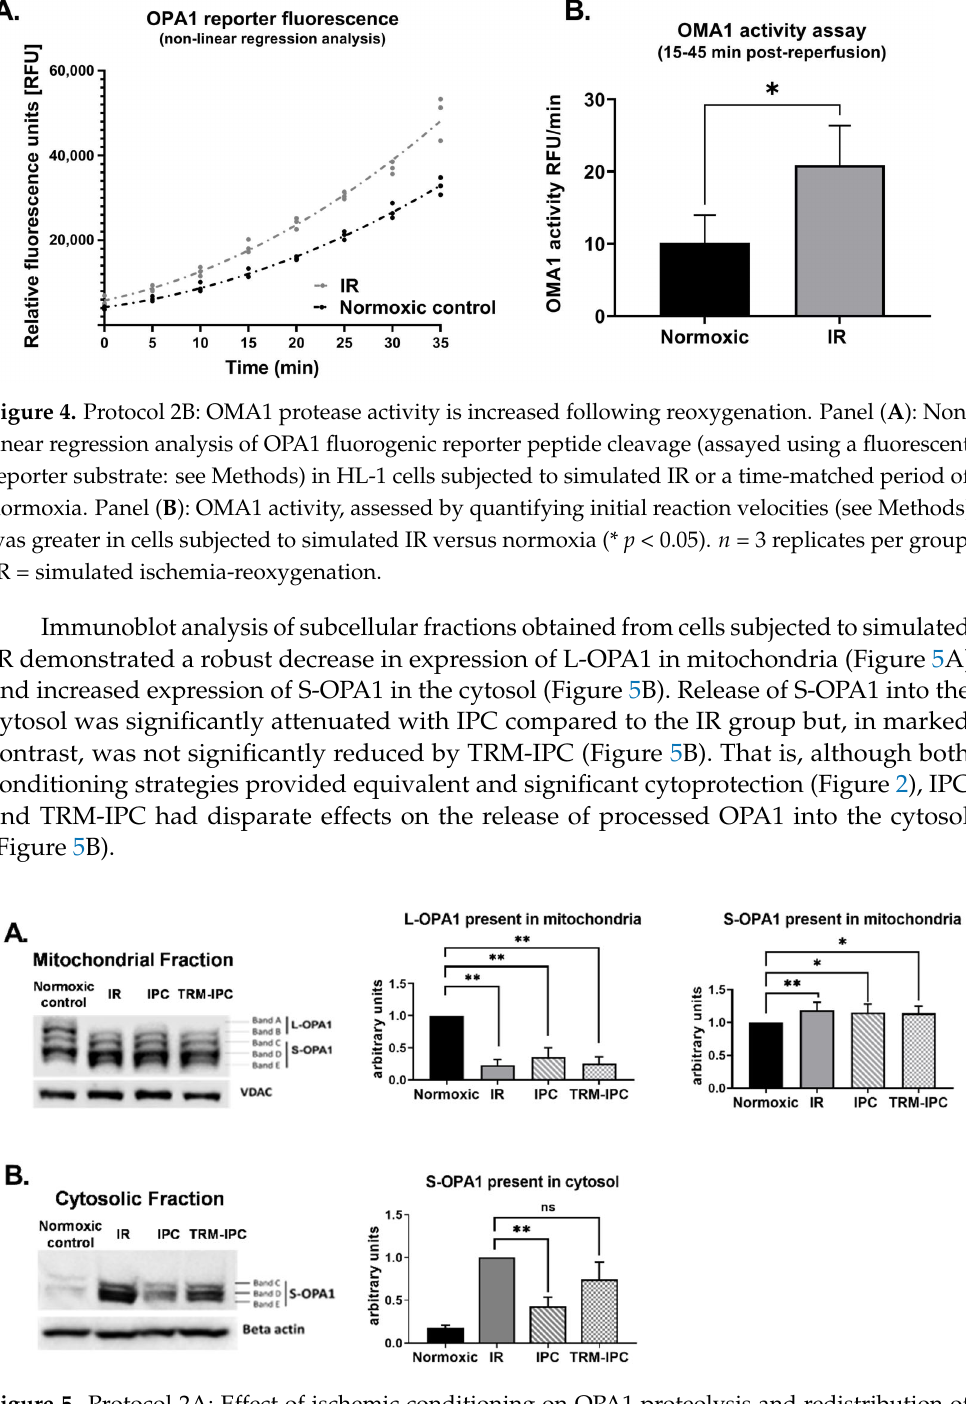
Figure 5. Protocol 2A: Effect of ischemic conditioning on OPA1 proteolysis and redistribution of S-OPA1. Original immunoblots ( left panels ) and quantified fold-changes (right panels) in expression of OPA1 mitochondrial and cytosolic fractions of HL-1 cells subjected to IPC, TRM-IPC, simulated IR or a matched period of normoxia. Panel ( A ). Significant processing of L-OPA1 was observed in IR, IPC and TRM-IPC groups versus normoxia (* p < 0.05; ** p < 0.01). Panel ( B ). Simulated IR was associated with release of S-OPA1 into the cytosol, an effect that was significantly attenuated by IPC (** p < 0.01) but not by TRM-IPC (ns = not significant). n = 5 replicates per group; normalized to beta- actin (cytosolic) or VDAC (mitochondria) loading controls. IR = simulated ischemia-reoxygenation, IPC = ischemic preconditioning, TRM-IPC = transfer of IPC ‘reperfusate’